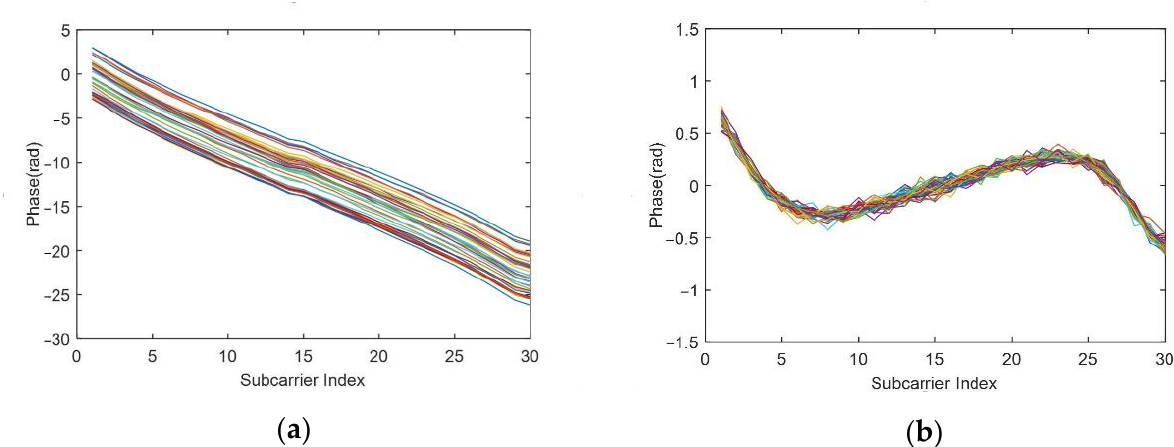
Figure 7. CSI phase of 40 packets before and after sanitisation. ( a ) Unwrapped CSI phase. ( b ) CSI phase after sanitisation.